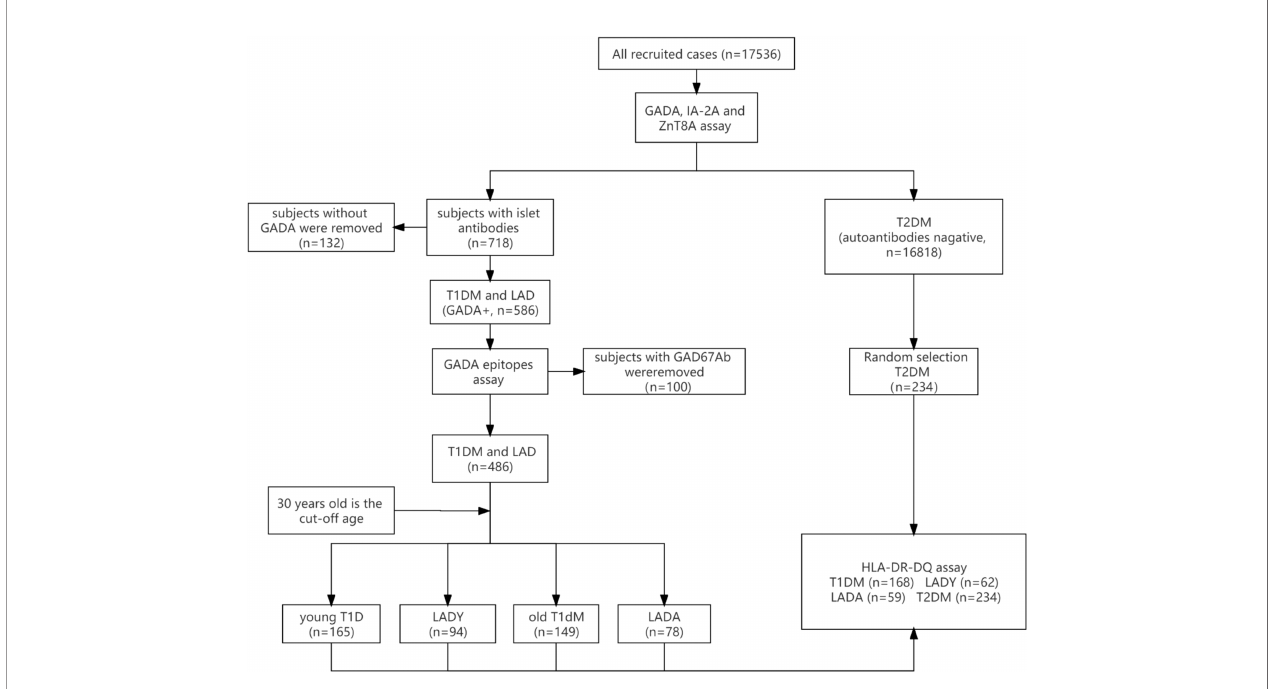
FIGURE 1 | Flowchart of sampling, grouping, assaying and